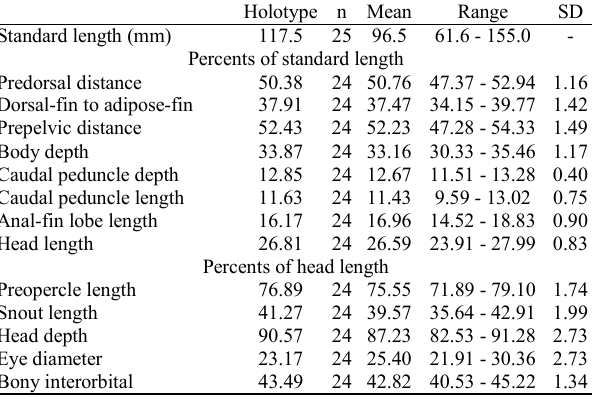
Table 1. Morphometric data for Leporinus santosi . SD = Standard